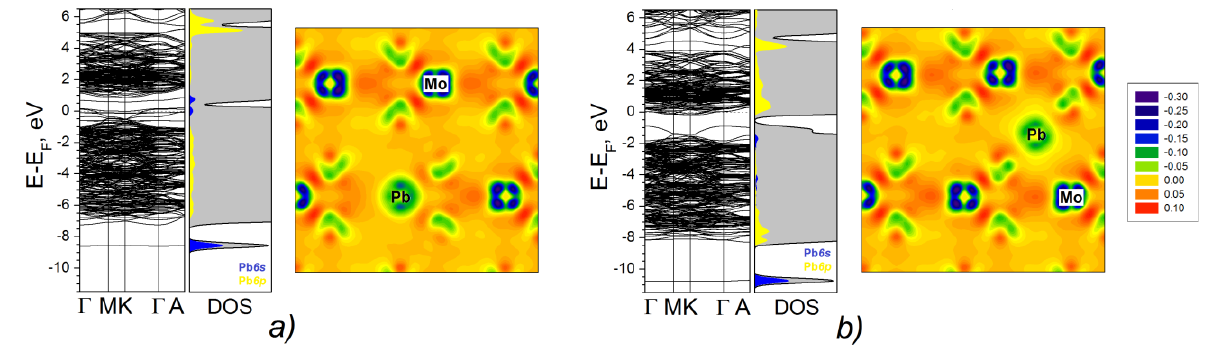
Figure 5. ( a ) Band structure; electronic partial densities of states (DOS) for Pb and differential electron density map for 2H-MoS structure, DOS for Pb and differential electron density map for 2H-MoS intercalated by single Pb atom. LDA DFT